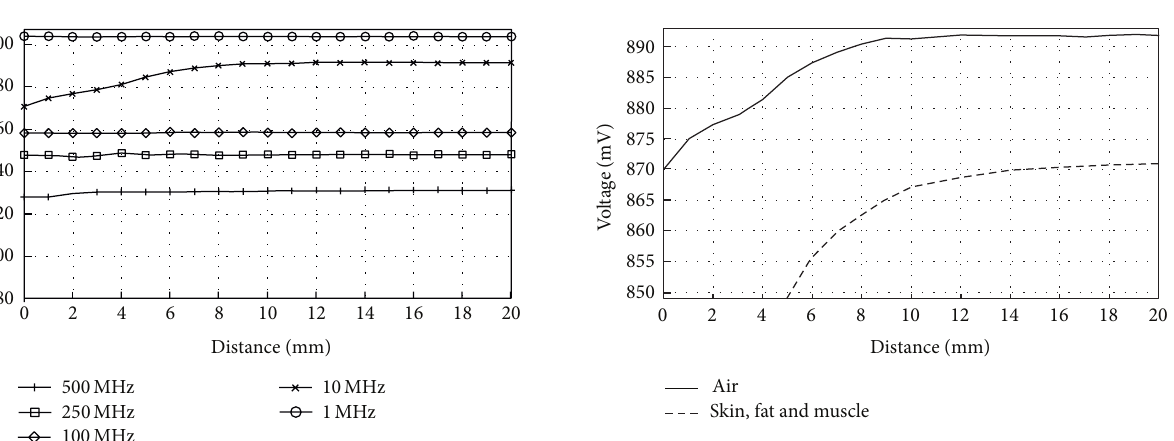
Figure 12: Voltage variations on reader coil versus distance. Transmission medium between coils: air. Measurements were done for various frequencies (1MHz, 10 MHz, 100MHz, 250 MHz, and 500 MHz).